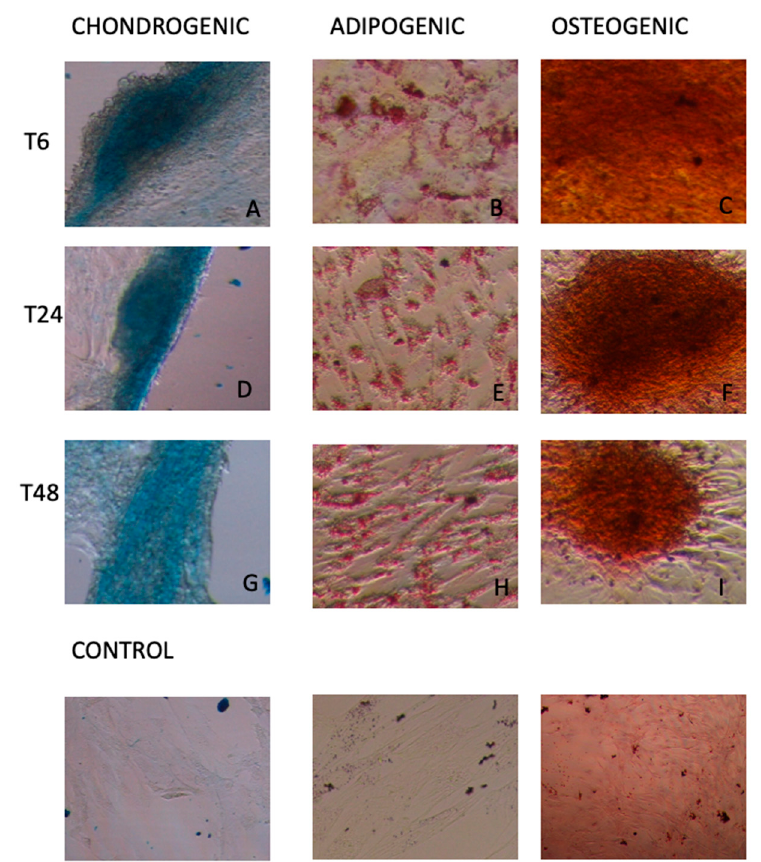
Figure 6. Stored eATMSCs, cultured in induction medium for two weeks and stained for chondro- genic, adipogenic and osteogenic differentiation. T6: ( A ) cells stored in plasma at 4 °C; ( B ) cells stored in plasma at RT; ( C ) cells stored in saline solution at RT. T24: ( D ) cells stored in saline solution at 4 °C; ( E ) cells stored in plasma at 4 °C; ( F ) cells stored in plasma at RT. T48: ( G ) cells stored in saline solution at RT; ( H ) cells stored in saline solution at 4 °C; ( I ) cells stored in plasma at RT. Control groups are reported. Magnification 10×.